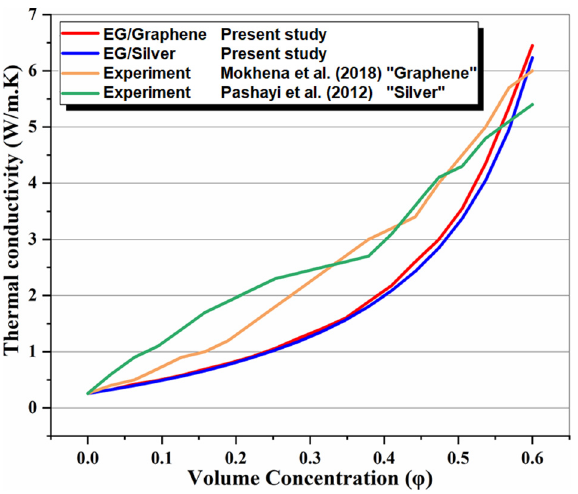
Figure 2. Comparison of effect of nanoparticle volume concentration on nanofluid thermal conduc- tivity with experimental studies [48,49]. Table 6. Comparison of present study results with work of Eldessouky and Ettouney [34], to validate the MSF desalination